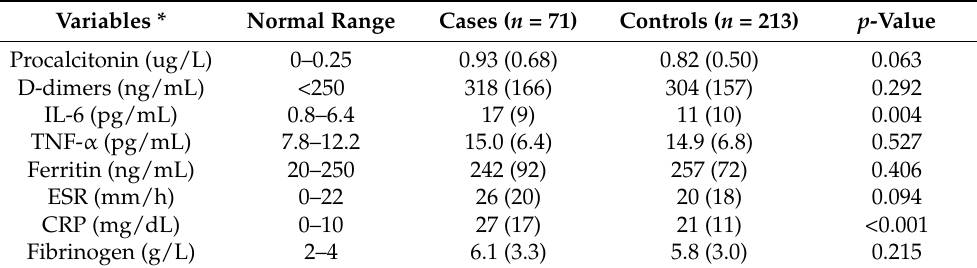
Table 5. Comparison of cytokines and inflammatory markers at ICU admission between cases and controls.